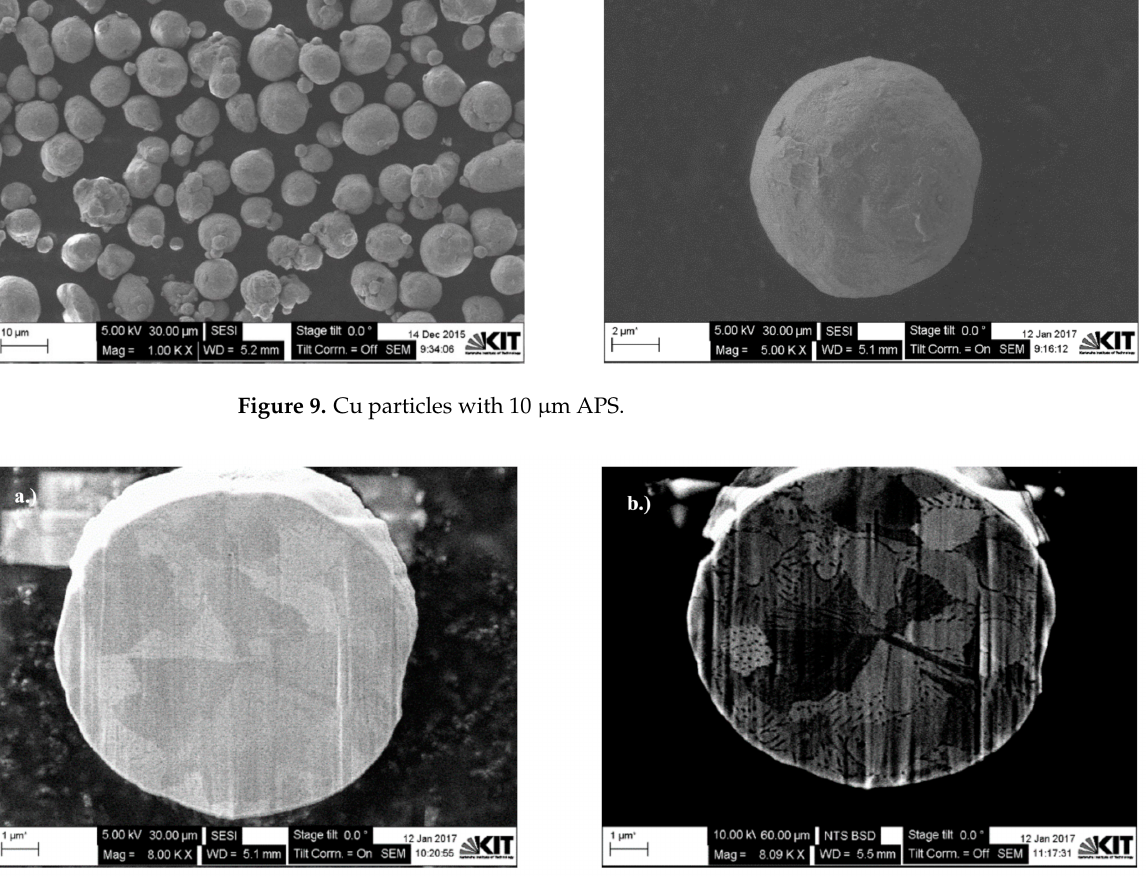
Figure 10. Dual FIB-SEM images of the sectioned Cu particle with 10 µ m APS using ( a ) SESI and ( b ) NTS BSD detector